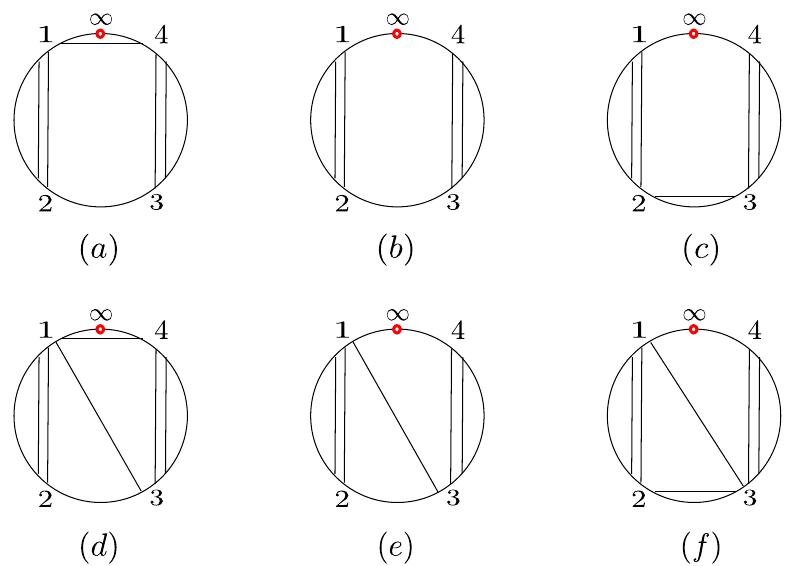
Figure 11 . Examples of the diagrams that live at the left boundary of the moduli space. ( a ){( c ) are the ones without diagonal contractions while ( d ){( f ) are the ones with diagonal contractions. Depending on the relative lengths of the operators, the diagrams have di(cid:11)erent topology at the boundary of the moduli